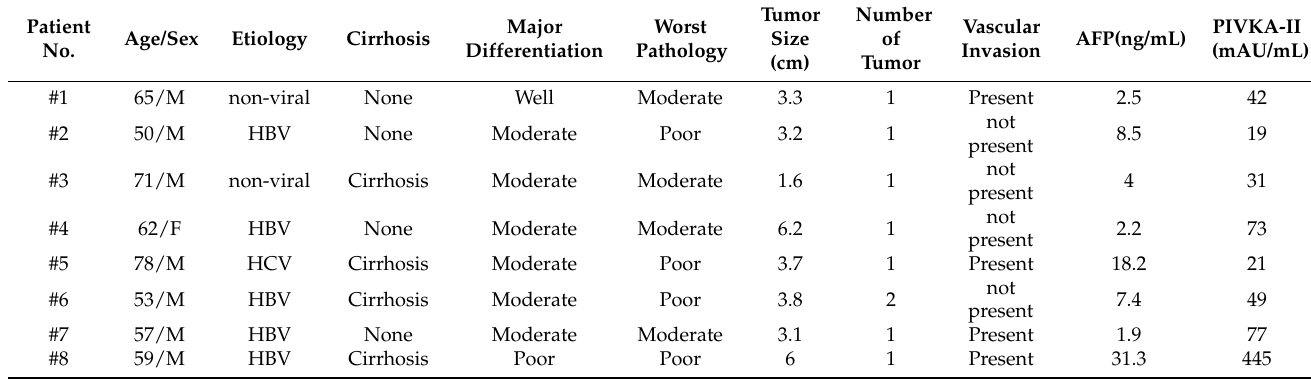
Table 1. Baseline characteristics of patients related to